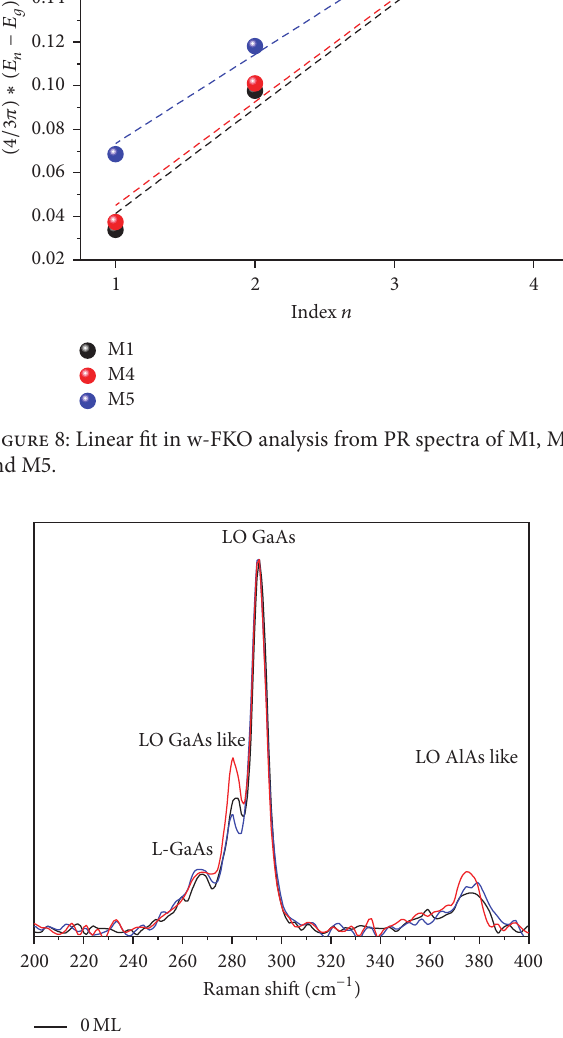
Figure 10 plots the surface electric field obtained by PR (black point) and Raman intensity ratio 𝐼